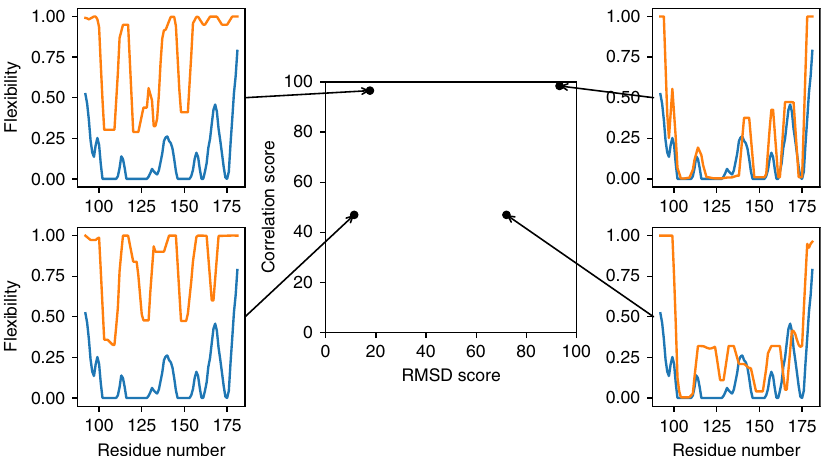
Fig. 1 ANSURR analysis of four models from NMR ensembles for the DNA binding domain of the human Forkhead transcription factor AFX (PDB ID 1e17). In the four plots, the blue lines show the fl exibility predicted by RCI while the orange lines show fl exibility predicted by FIRST. In the center of the fi gure is the ANSURR analysis showing the RMSD and correlation scores derived from the four models. The two models on the right are from the CNW dataset 27 (re fi ned in explicit solvent), while the two on the left are from the CNS set (re fi ned in vacuo). As is typical, the CNW-re fi ned structures have better RMSD, meaning that the calculated fl exibilities compare well on average. The two models at the bottom have poor correlations, because the locations of the peaks do not match well between RCI and FIRST. The two at the top both have good correlations, because the locations of the peaks do match, even though (in the case of the top left structure) their heights are very